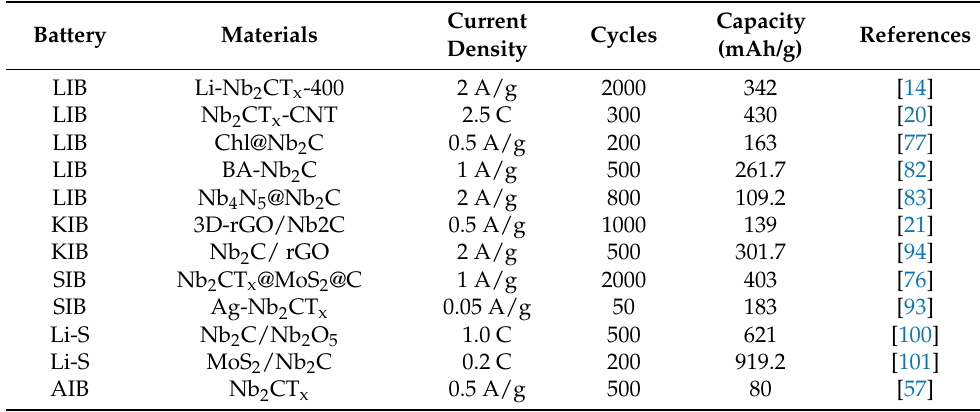
Table 2. The specific capacities of Nb 2 CT x for secondary